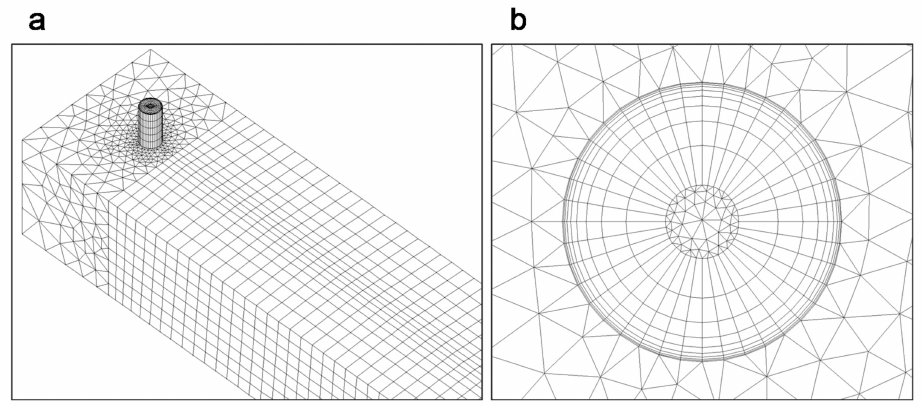
Figure 5. ( a ) Isometric view of the computational grid near the inlet of the EAHE. ( b ) Close-up view of the face mesh near the EAHE’s